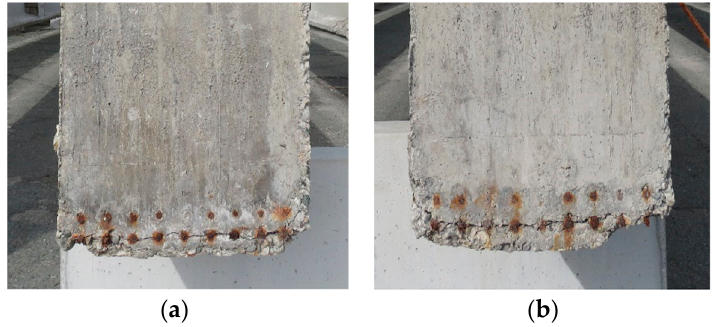
Figure 6. Cracks on the end of the ( a ) B3-P47/46 and ( b ) B4-P47/46 beams.